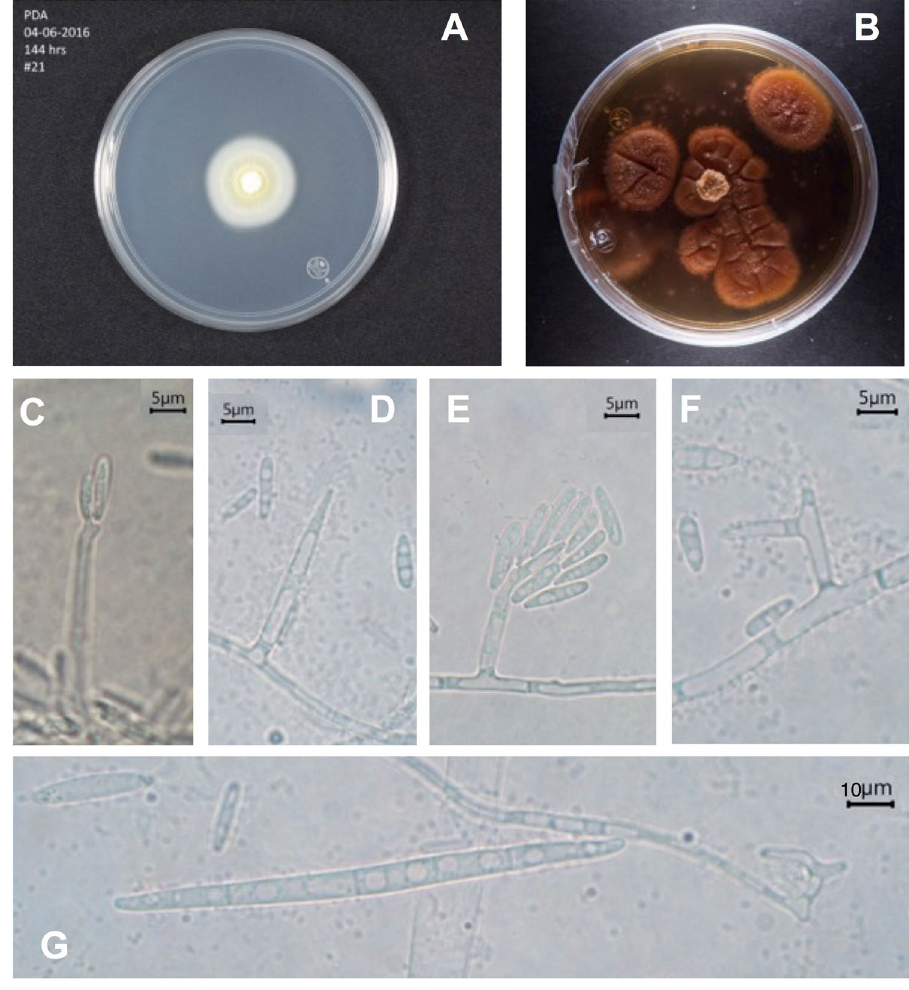
Figure 3. Coniochaeta cipronana . ( A ) PDA Culture ca 6 days. ( B ) PDA Culture ca 20 days. ( C – E ) Conidiogenous cell with small conidia. ( F ) Dicotomic conidiophore. ( G ) Macroconidia 5–7